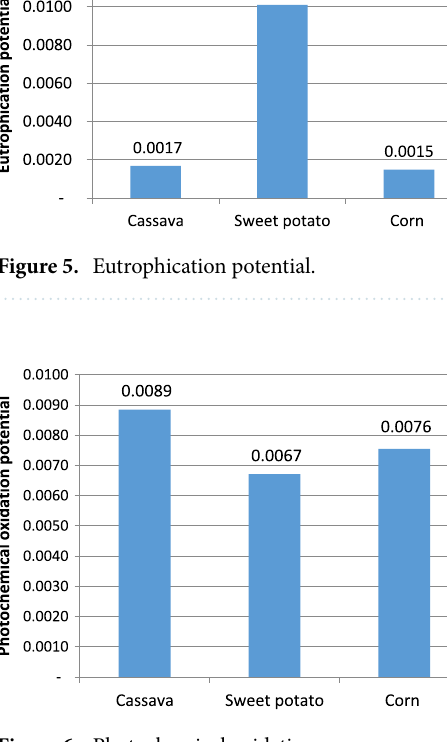
Figure 6. Photochemical